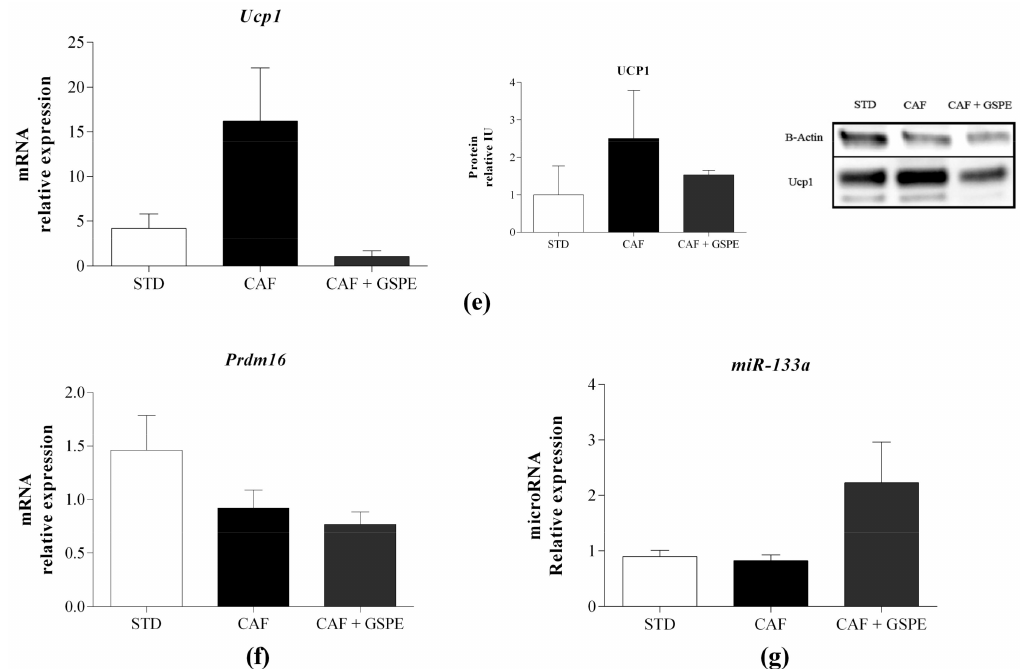
Figure 2. Effect of the long-term administration of a grape seed proanthocyanidin extract (GSPE) with an obesogenic diet on the expression of genes related to adipogenesis and browning in retroperitoneal white adipose tissue. Rats were fed either a standard chow diet (STD group, n = 10), a cafeteria diet (CAF group n = 10), or a cafeteria diet with daily administration of 200 mg GSPE/kg BW (CAF + GSPE, n = 10) for 12 weeks. ( a ) Level of peroxisome proliferator activated receptor gamma (Ppar γ ) mRNA; ( b ) Level of CCAAT/enhancer binding protein (C/EBP) beta (C/ebp β ) mRNA; ( c ) Level of Ppar γ coactivator 1 alpha (Pgc1 α ) mRNA; ( d ) Level of Sirtuin 1 (Sirt1) mRNA; ( e ) mRNA and protein levels of uncoupling protein 1 (UCP1); ( f ) Level of PR domain containing 16 (Prdm16) mRNA; ( g ) microRNA-133a levels. The values are the means ± SEM. Statistical analyses were performed using the t -test. Different letters indicate significant differences between groups when p ≤